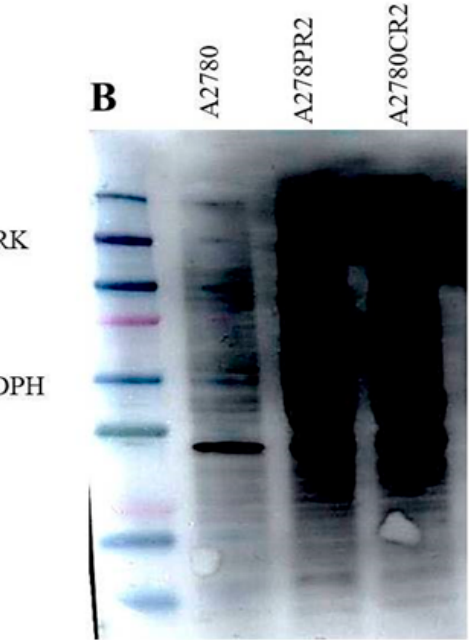
Figure 3. ( A ) PTPRK protein expression analysis in the A2780 and drug-resistant cell lines: A2780CR2 and A2780PR2. The cellular proteins were separated using 7% PAGE and transferred to a PVDF membrane, which was then immunoblotted with either primary antibody (Ab) or HRP-conjugated secondary Ab. A primary anti-GADPH Ab was used as a loading control for the cell lysates; ( B ) total pTYR protein expression analysis in the A2780 and drug-resistant cell lines A2780CR2 and A2780PR2. The cellular proteins and protein molecular weight marker were separated using 7% PAGE and transferred to a PVDF membrane, which was then immunoblotted with either primary Ab or HRP-conjugated secondary Ab.